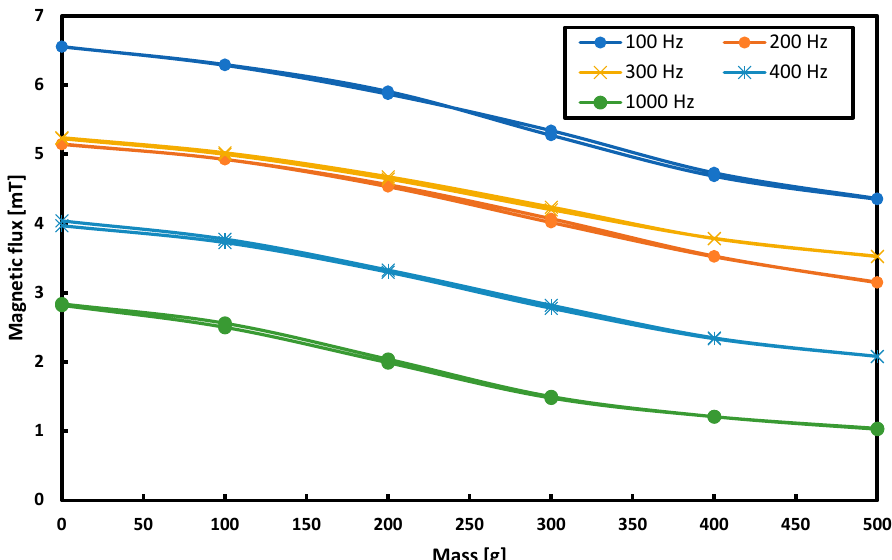
Mass [g] Figure 13. The dependence of the magnetic flux changes on the load for different frequencies of the supply current. The maximum measurement hysteresis errors for different frequencies of the sine function are shown in Figure 14.